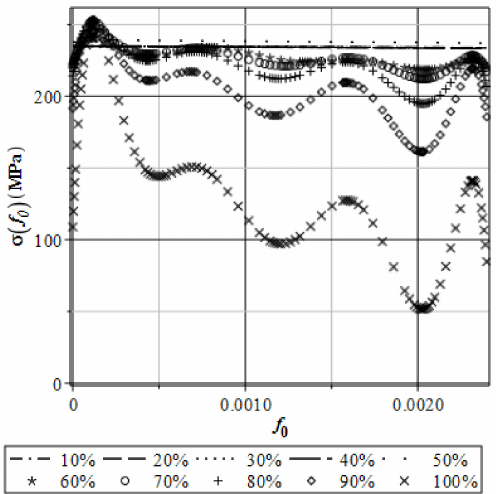
Figure 6. Response function polynomials for stress as a function of f 0